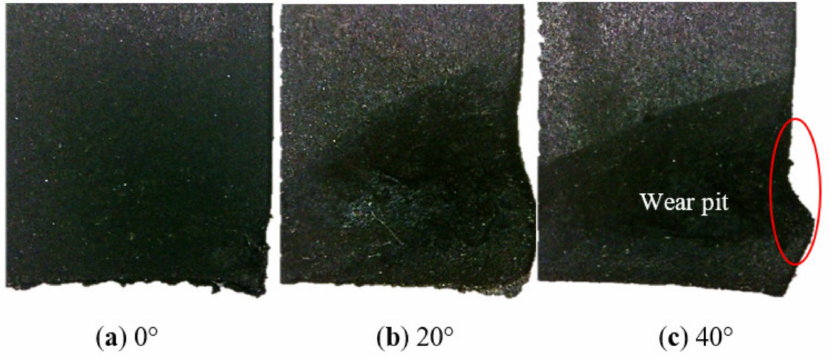
Figure 13. The changes of the junction of the slide surface and front surface with slip